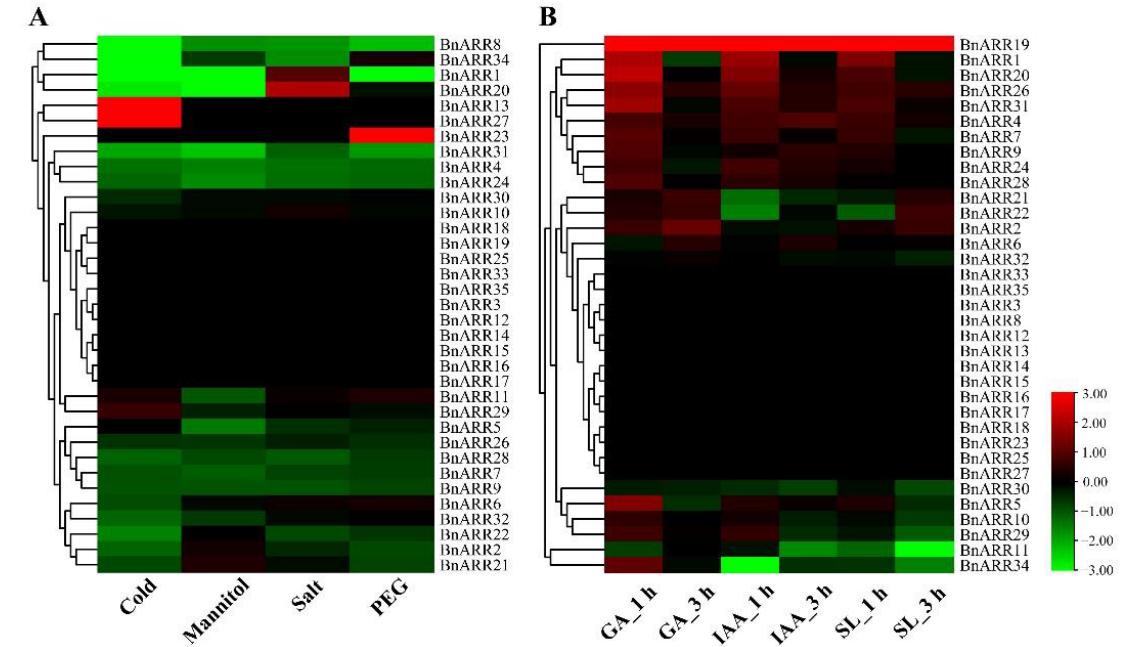
Figure 8. Type-B BnARR expression in response to abiotic and hormone treatments. ( A ) BnARR expression under abiotic stresses. ( B ) BnARR expression under hormone treatments.